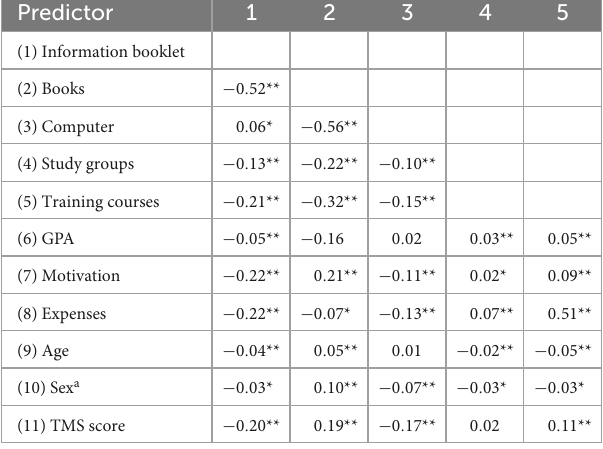
TABLE 5 Pearson correlations of predictors with relative time spent on each preparatory activity. Predictor